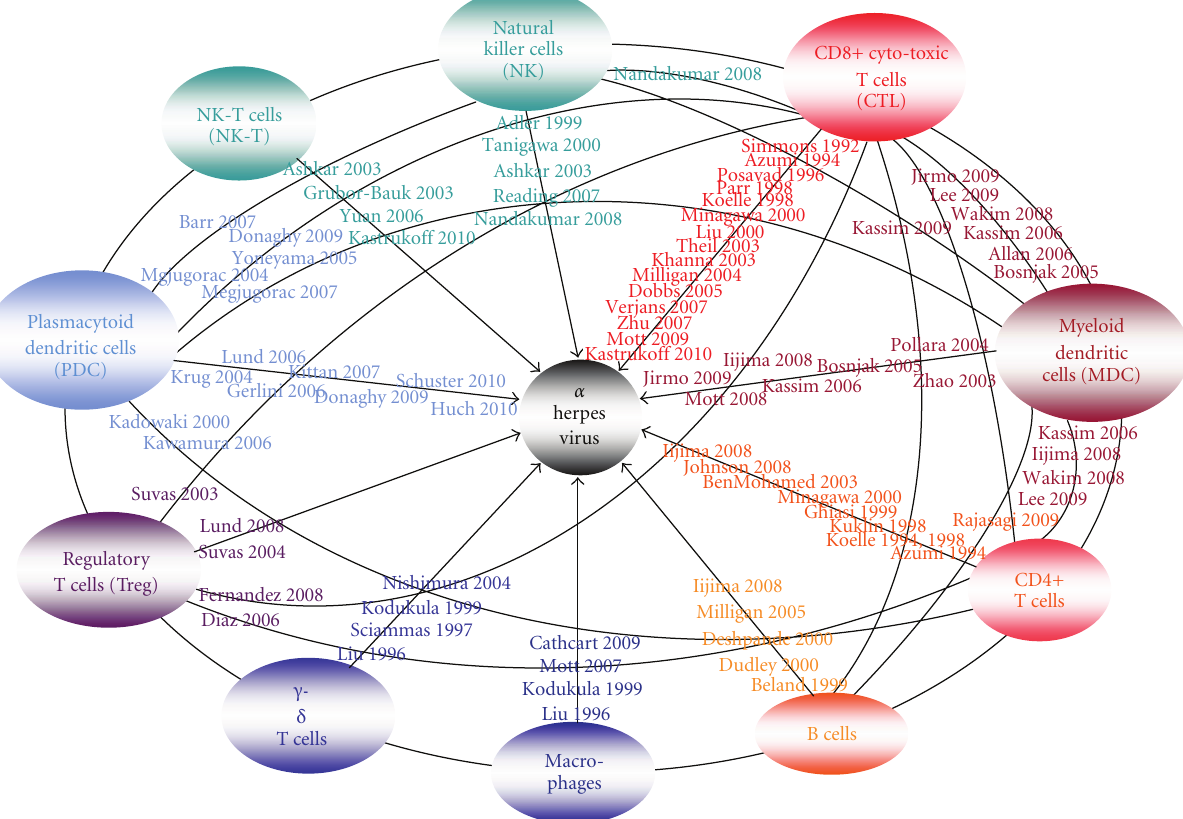
Figure 1: “Spider web” for the control of alpha herpes virus infections by cells of the innate and adaptive immune system (left and right side of the figure,